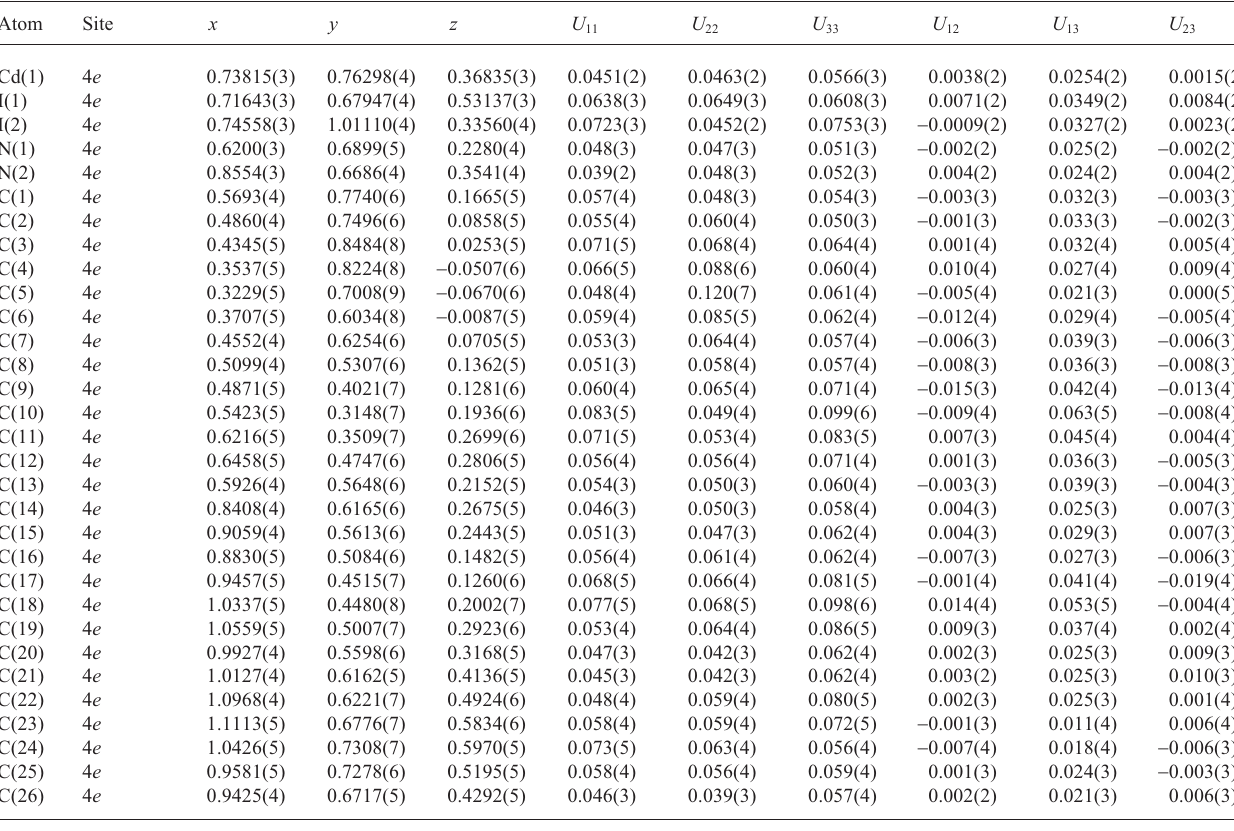
Table 3. Atomic coordinates and displacement parameters (in Å 2 )